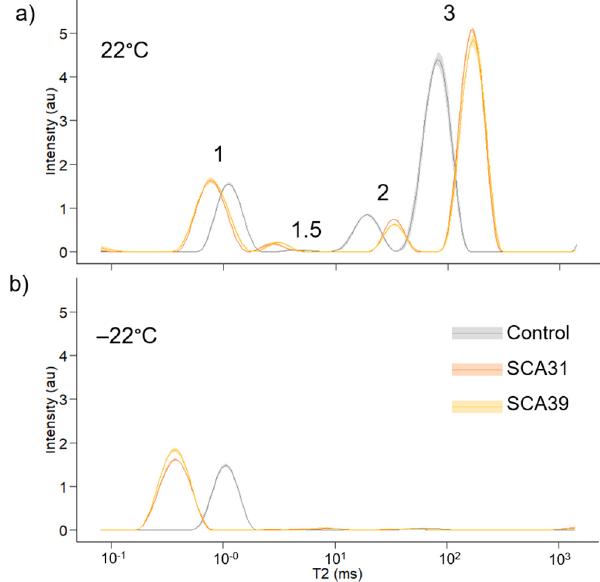
Figure 5. Low-field nuclear magnetic resonance T 2 relaxation time distributions of control, 31% sorbitol citric acid and 39% sorbitol citric acid modified samples. Solid dark lines represent average distributions for four replicates for each treatment and lighter shading shows the standard deviation. ( a ) measurement at 22 ◦ C; ( b ) measurement at − 22 ◦ C. Table 3. Relative peak areas and peak maximum T 2 values for control, 31% sorbitol citric acid and 39% sorbitol citric acid modified samples measured at 22 ◦ C. Standard deviation of four replicates in parentheses.